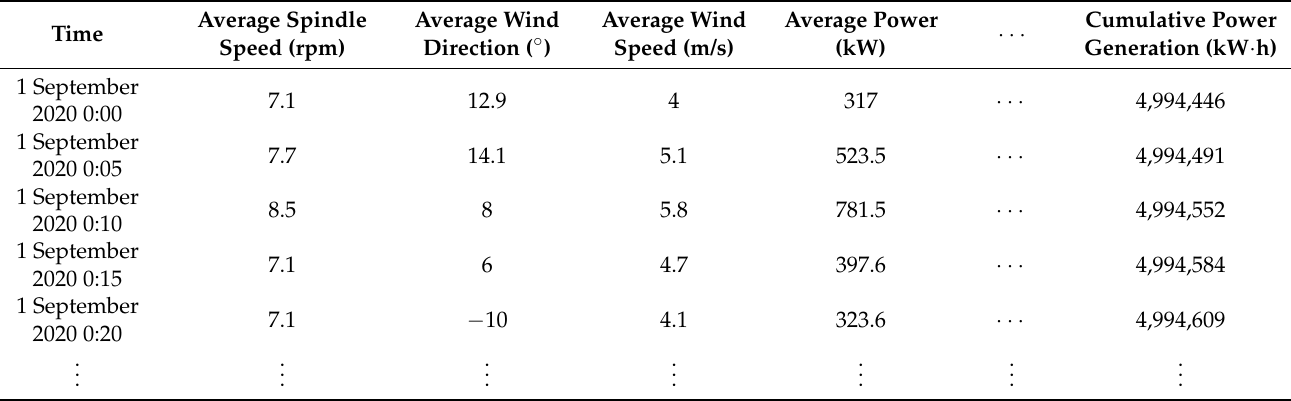
Table 3. Raw SCADA data.